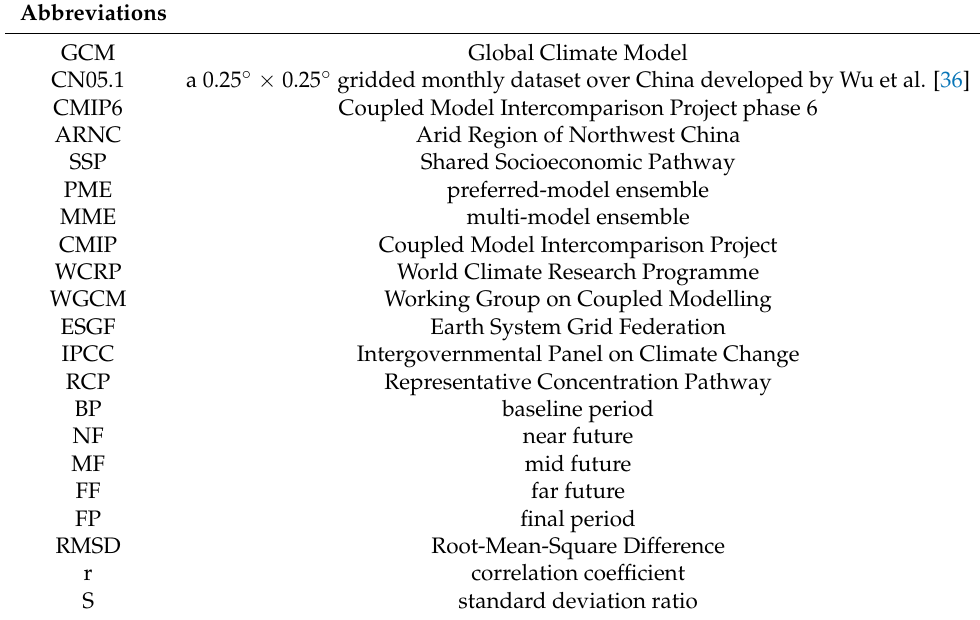
Table 1. Important nomenclature.